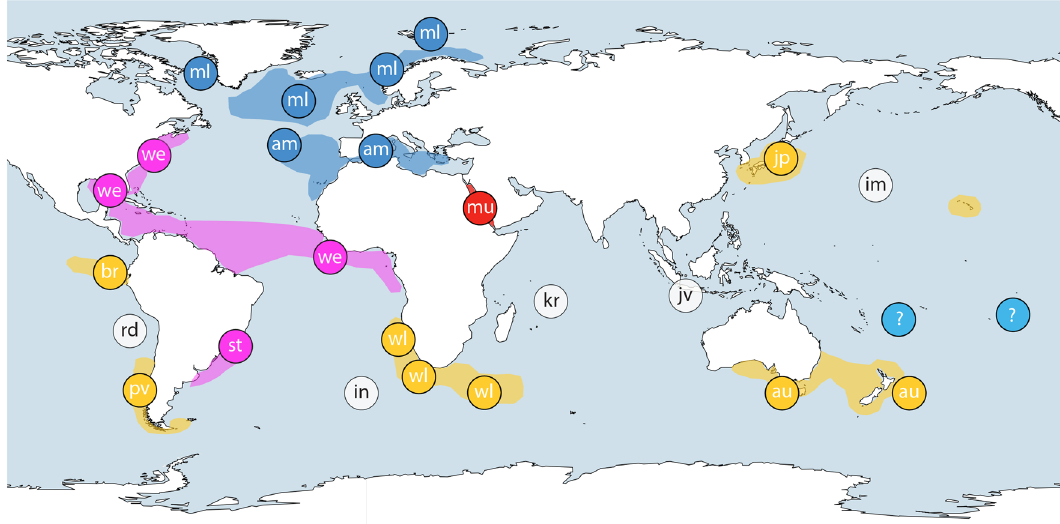
Figure 6. Revised map of Maurolicus species distribution. Representation of current genetic groupings for Maurolicus , colour coded to reflect COI haplotype groupings and suggested putative species: (1) M. muelleri ; (2) M. australis ; (3) M. mucronatus ; (4) M. weitzmani and (5) a presently uncharacterised Maurolicus species from the central South Pacific. Unsampled species are indicated as in Fig. 1. The base map was constructed from the GSHHG World Vector Shoreline data set (WVS; Version 2.3.7) using the open source QGIS 19 . Symbols were added using Adobe